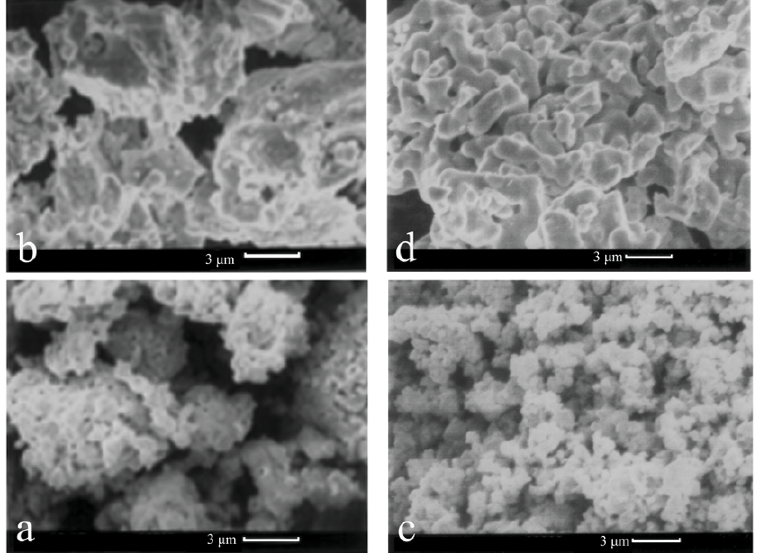
Figure 14. Scanning electron micrographs of sol-gel derived (a) LaCoO